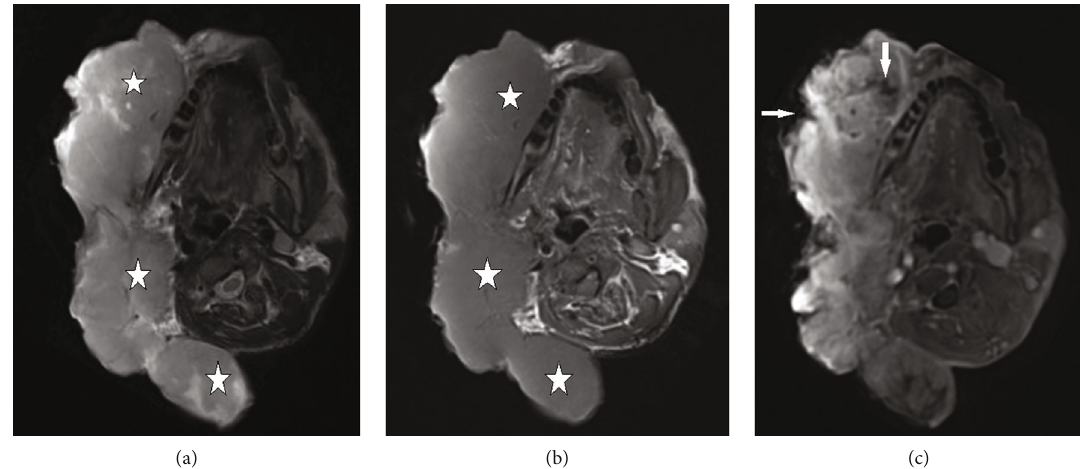
Figure 2: Axial MRI of the head showing a large lobulated mass centered at the right preauricular region. (a) The lesion appearing hypointense on T1-weighted imaging, (b) moderately hyperintense on T2-weighted imaging, and (c) showing marked homogeneous contrast enhancement with peripheral and intratumoral zones of necrosis (white arrows) on T1-weighted imaging after gadolinium administration. The masseter muscle and perioral muscles are not separately visible due to deep muscular invasion. There is also deep invasion of the tumour behind the right mandibular ramus in the masticator